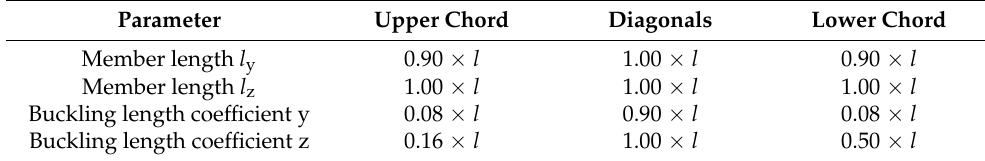
Table 1. Structural parameters of steel structural elements in the given